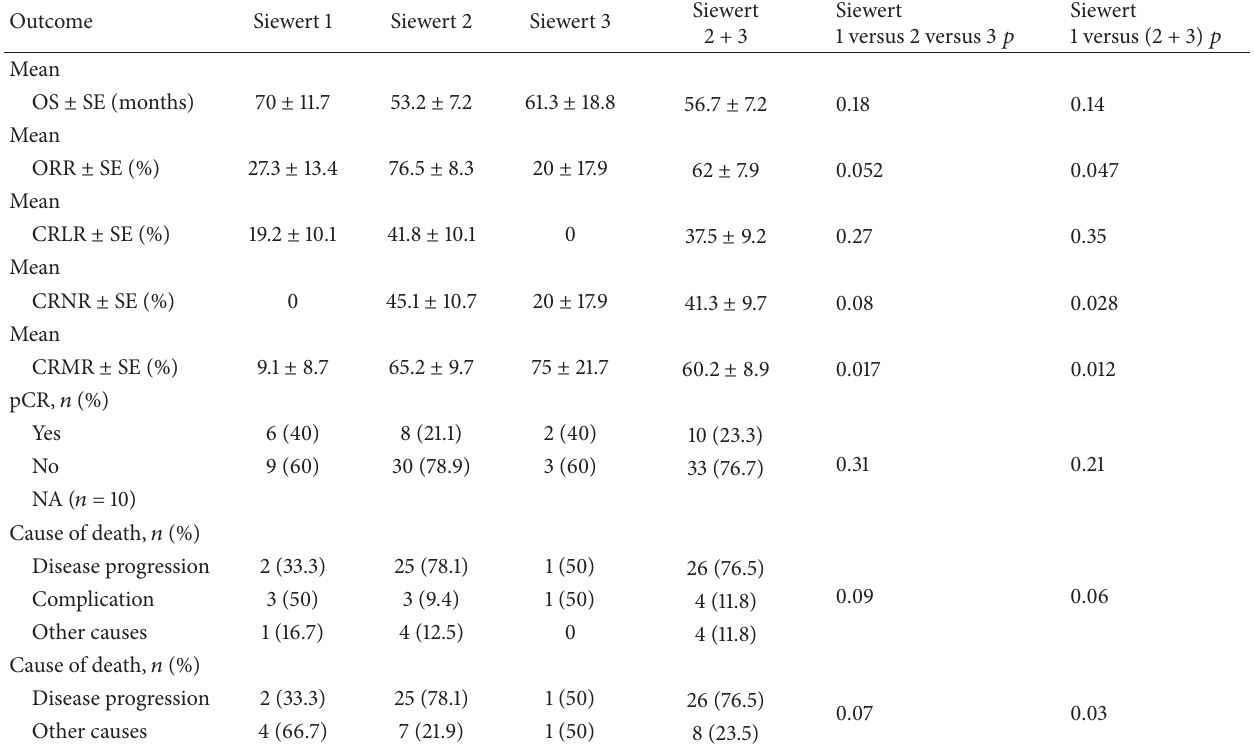
Table 3: Outcome of patients according to Siewert classification.